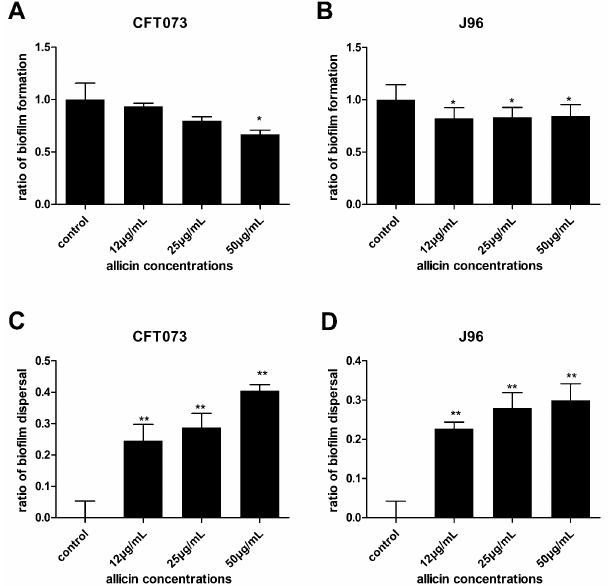
Figure 3. The effect of sub-inhibitory concentrations (sub-MICs) of allicin on UPEC biofilm formation ( A , B ) and dispersal ( C , D ). The biofilm values were normalized with respect to growth values ( A , B ). The biofilm formation was evaluated by measuring OD value at 595 nm and represented as ratio of biofilm formation relative to control, set at 1. Ratio of biofilm dispersal = (OD value of control − OD value of allicin treatment)/OD value of control. Values shown denote the mean ± SD of three independent experiments in triplicate, * and ** mean statistically significant differences compared to control with values p < 0.05 and p < 0.01,